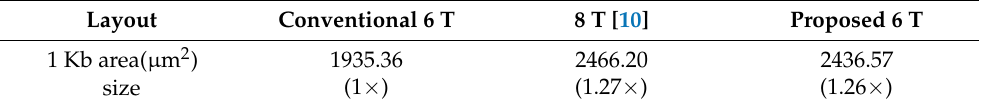
Table 2. Comparison table of the SRAM area.